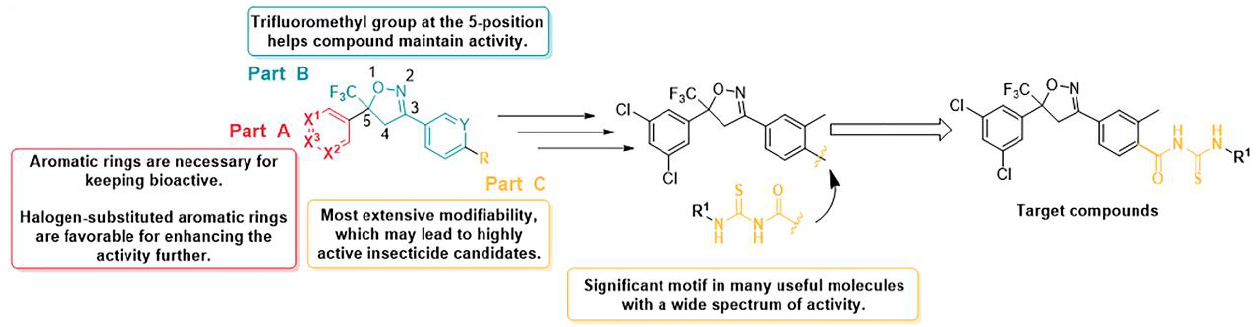
Figure 1. Design of the target compounds.